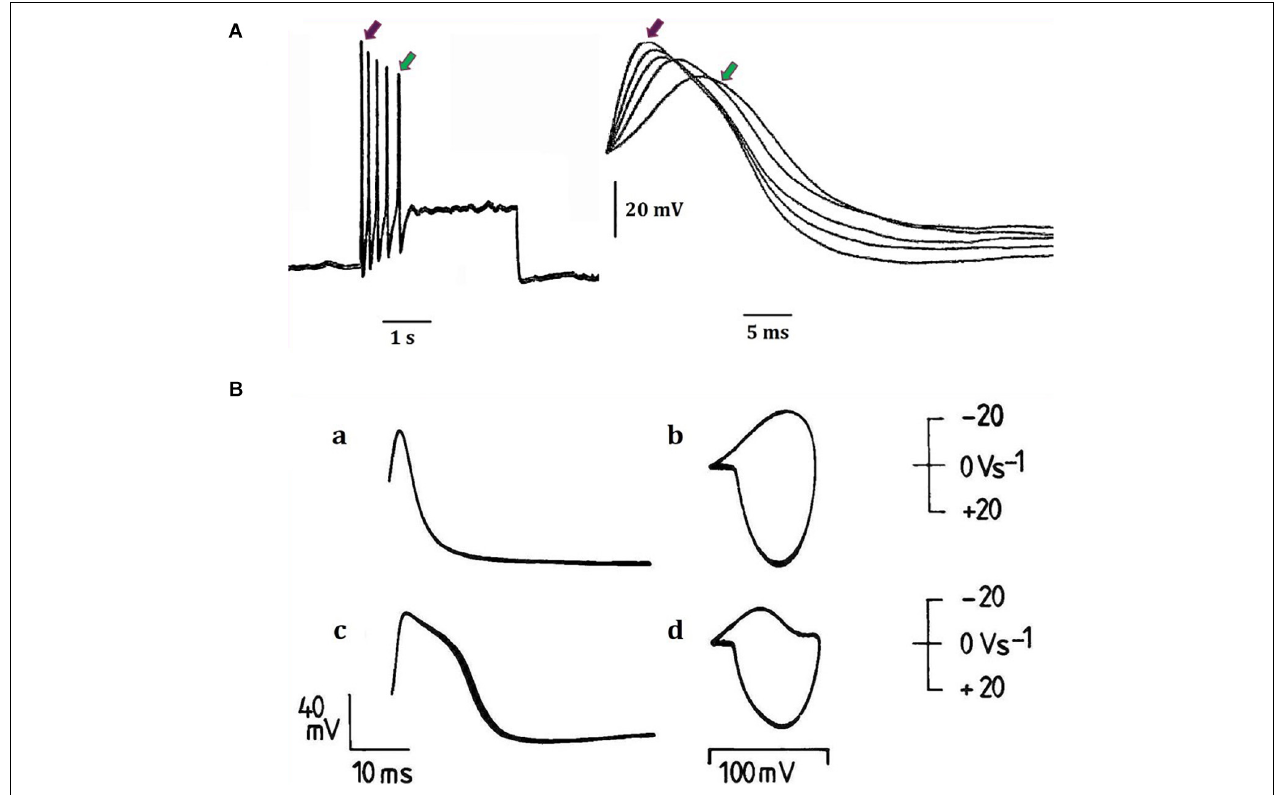
FIGURE 2 | Examples of action potential plasticity from identified neuronal somata of the great pond snail Lymnaea stagnalis (L.) (for locations and properties and functions (where known) of neurons and cell clusters, see Slade et al., 1981; Winlow and Polese, 2014). (A) Action potentials from a fast-adapting pedal I cluster cell, which was normally silent and was activated by a 3 s, 0.4 nA pulse injected into the cell via a bridge balanced recording electrode. The same five spikes are shown in each case: (a) on a slow time base, (b) on a faster time base. The red and green arrows indicate the first and last spikes respectively in each case. Note the temporal variability between spike peaks (previously unpublished data provided from William Winlow’s data bank). (B) Different types of action potentials have different spike shapes (a and c) and trajectories as demonstrated in phase plane portraits (b and d) (a and b) demonstrate the same type 1 action potentials from an RPeF cluster neuron, while (c and d) demonstrate type 2 action potentials from an RPeB cluster neuron (adapted from Winlow et al., 1982 with permission). In the phase plane portraits, the rate of change of voltage (dV/dt) is plotted against voltage itself and the inward depolarizing phase is displayed downward, maintaining the voltage clamp convention. The technique is very useful for determining action potential thresholds (see Holden and Winlow, 1982 for details of the phase plane technique as shown